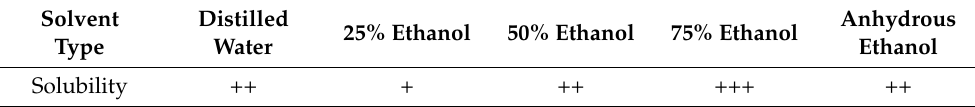
Table 2. The solubility of the pink pigment in ethanol